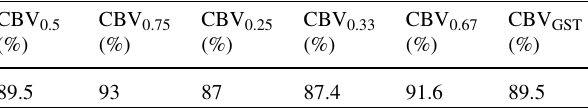
Table 10 CBV quantiles for Gastwirth median